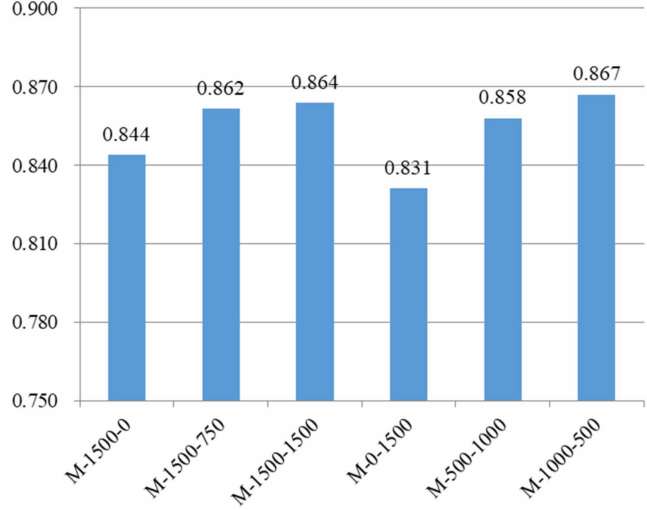
Figure 15. Prediction performance of each model (comprehensive